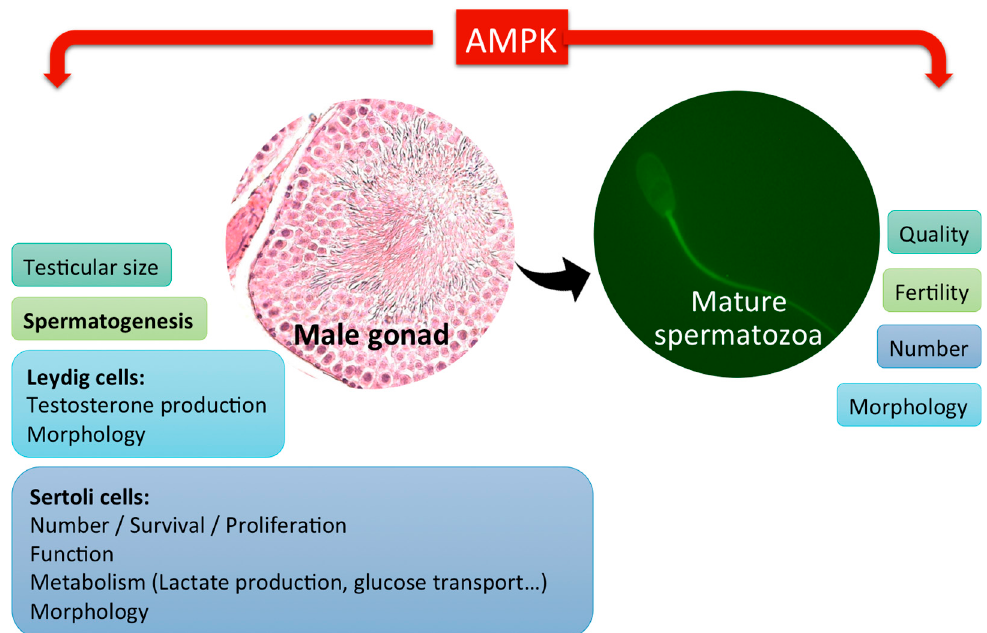
Figure 2. AMPK functions in male gonads and spermatozoa production. AMPK activity is involved in the control of the male gonad function, spermatozoa production and quality by its action also on the male gonadal somatic cells (Sertoli and Leydig cells).